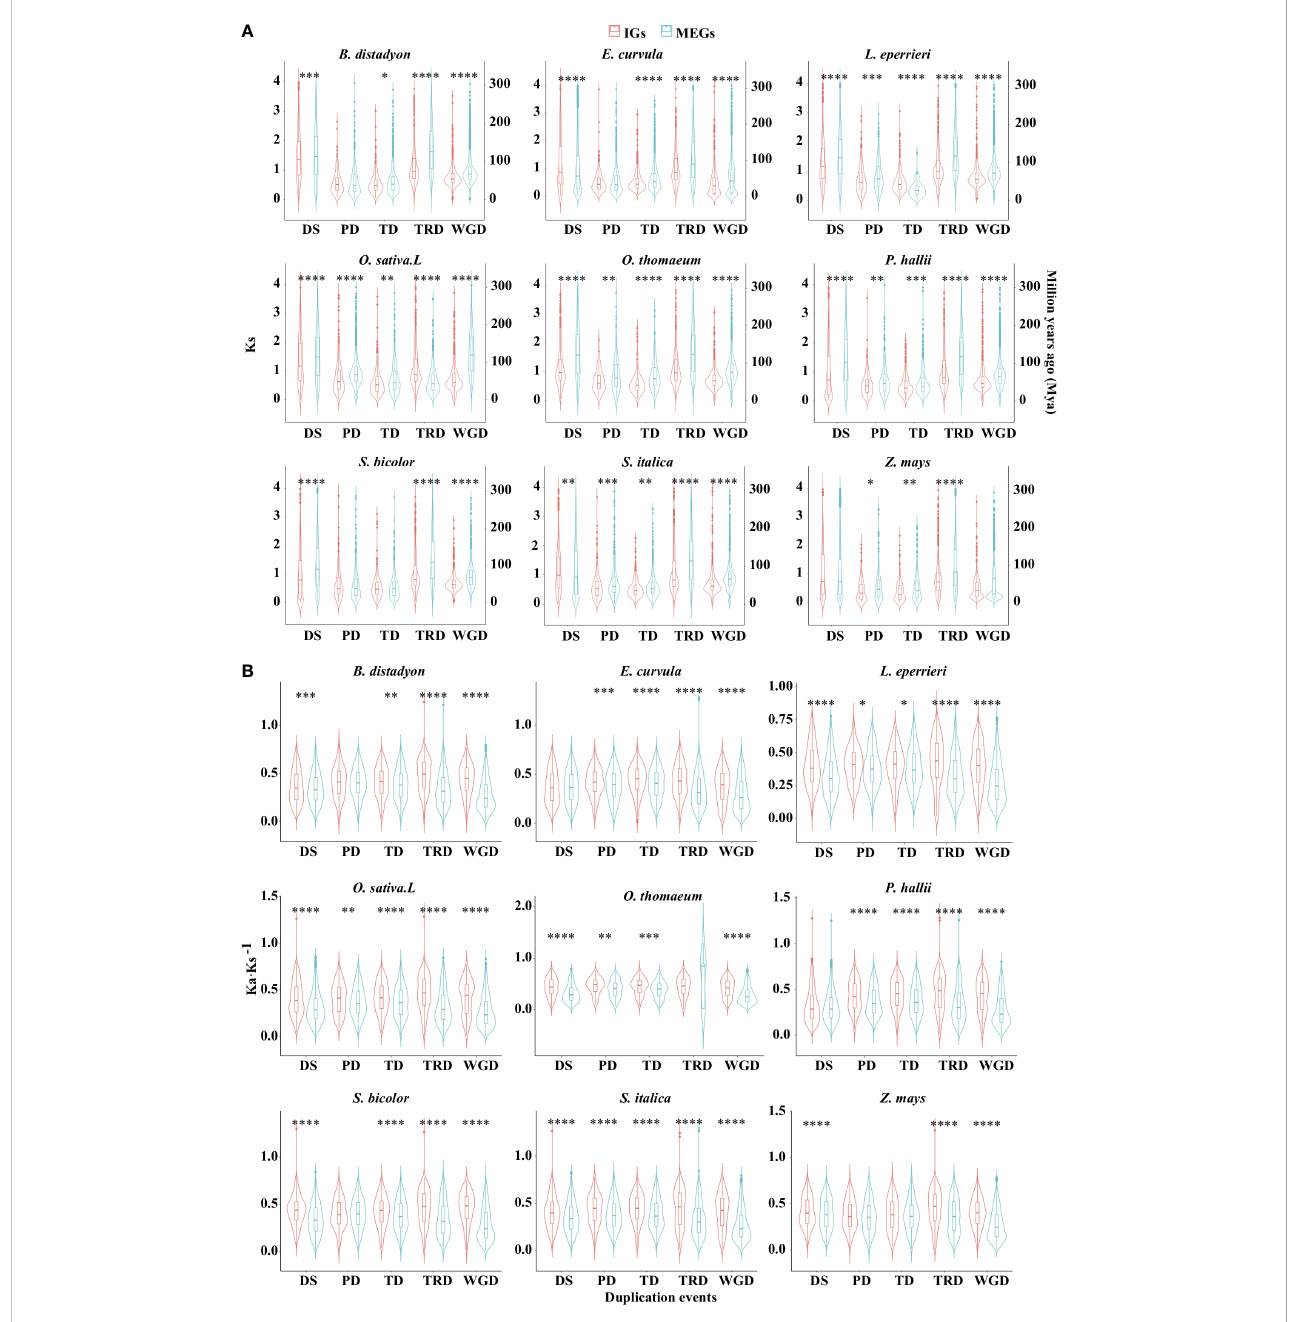
FIGURE 4 Distribution of Ks (A) and Ka·Ks − 1 (B) values for the IGs and MEGs derived from gene duplications. Dispersed (DSD), proximal (PD), tandem (TD), transposed (TRD), and whole-genome (WGD) duplications. Violin plots present the kernel probability density distribution. The overlaid boxplots present the data range and the distribution spread. The horizontal inner line represents the median value. The bars range from the 25th (bottom) to the 75th (top) percentile and the vertical lines represent 95% con fi dence intervals. Divergence time (T) was calculated as Ks·(2r) − 1 , where r is the neutral substitution rate (6.50 × 10 − 9 ). Asterisks represent signi fi cant differences (two-sided paired Wilcoxon sign test: * P < 0.05, ** P < 0.01, *** P < 0.001, **** P < 0.0001). The source data are provided in Supplementary Table